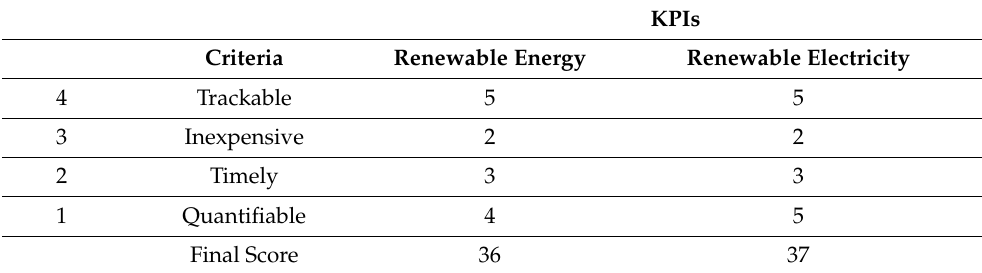
Table 5. Case study result of company B—target: increase renewable